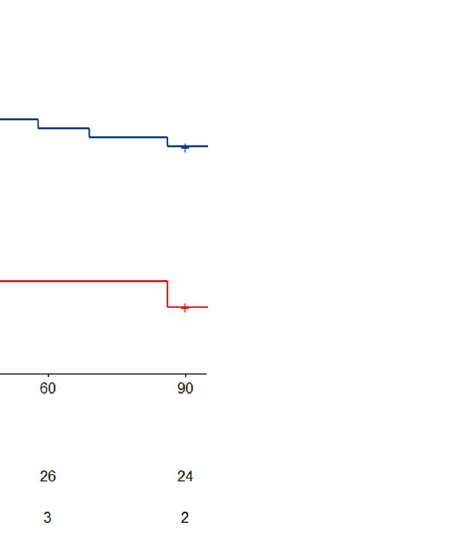
Fig 3. Survival curve according to the occurrence of a severe